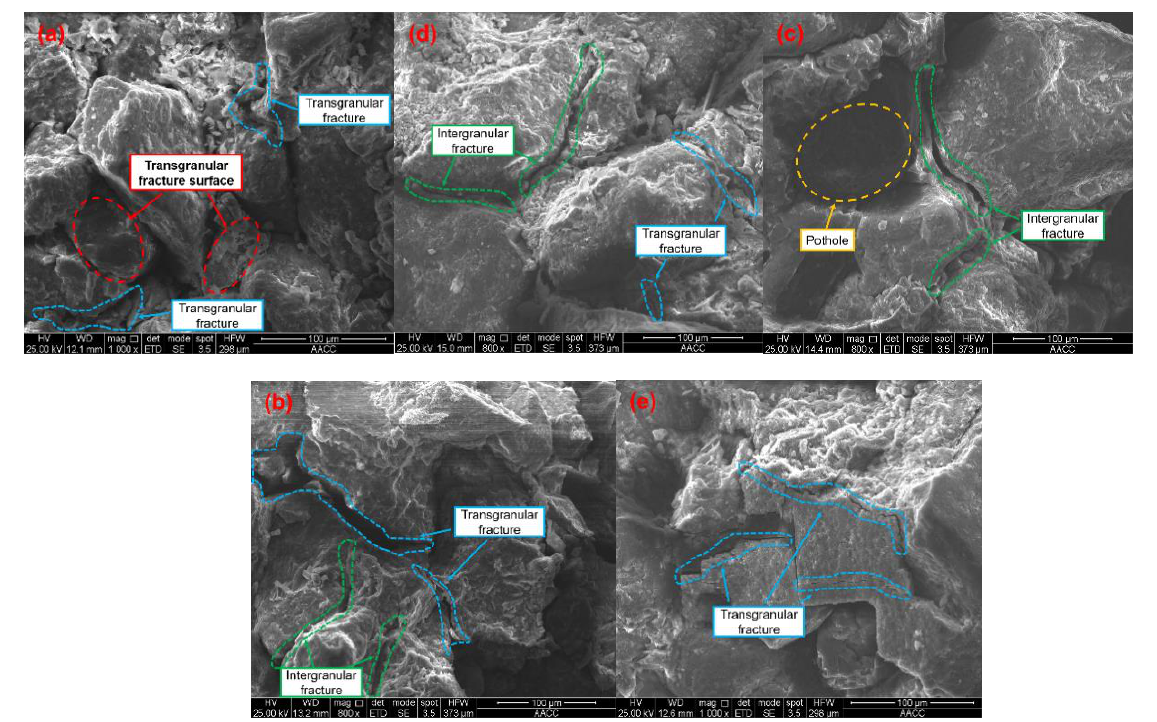
◦ ; ( b ) 22.5 ◦ ; ( c ) 45 ◦ ; ( d ) 67.5 ◦ : ( e ) 90 ◦